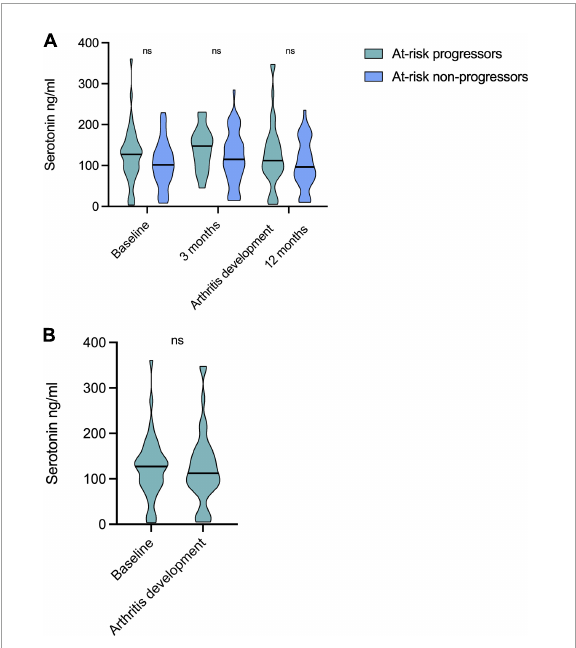
FIGURE2 Longitudinal serotonin levels in at-risk individuals. (A) Serotonin levels were relatively stable over time and no differences were seen between any time points for patients progressing to arthritis, nor for non-progressors. Patients progressing to arthritis had numerically higher levels compared to those not progressing at all time points, but not significantly different. (B) Serotonin levels at baseline (median 127 ng/ml) did not differ to those at the time for arthritis development (median 112 ng/ml) among progressors. ns, non significant.